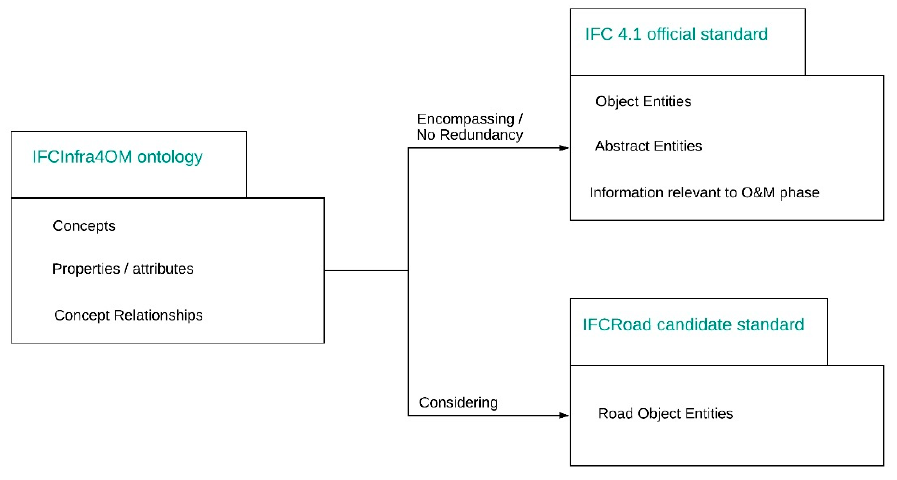
Figure 15. Extending Mechanism Proposed to Integrate IFCInfra4OM within IFC Schema.